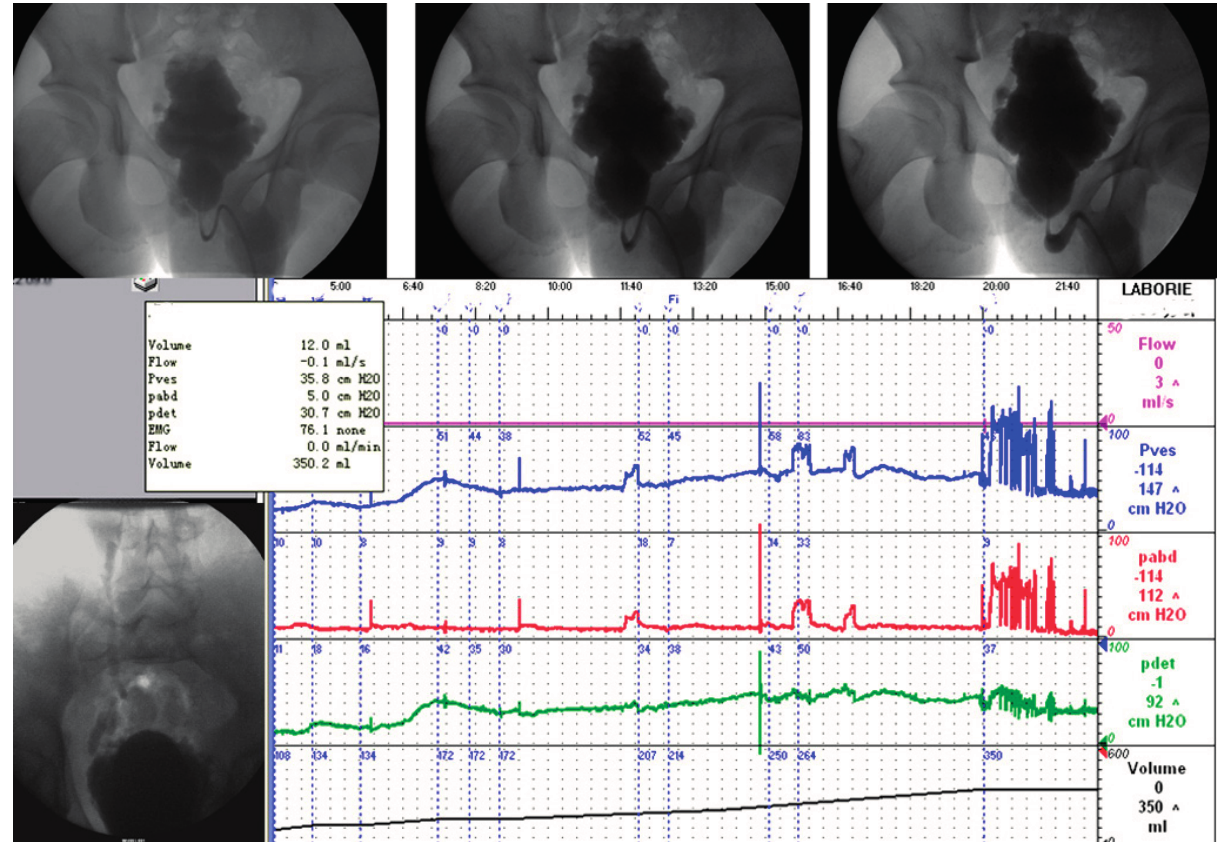
Figure 2. Video-urodynamics findings of patients with NB. Typical detrusor overactivity (DO), detrusor external sphincter dyssynergia (DESD), and right vesicoureteral reflux (VUR) are